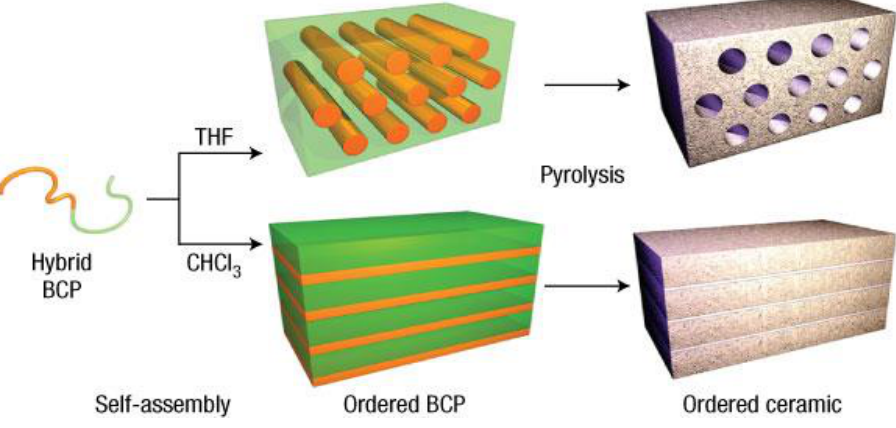
Figure 15. Conversion of a self-assembled hybrid block copolymer featuring an inorganic precursor segment into ordered ceramic structure by pyrolysis (reprinted with permission from Nature Publishing Group)